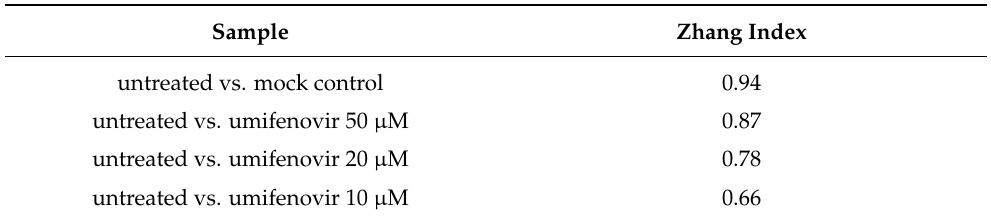
Table 2. Zhang indices for SARS-CoV-2 SRFIA on 96-well plate. Values are calculated from at least n = 6